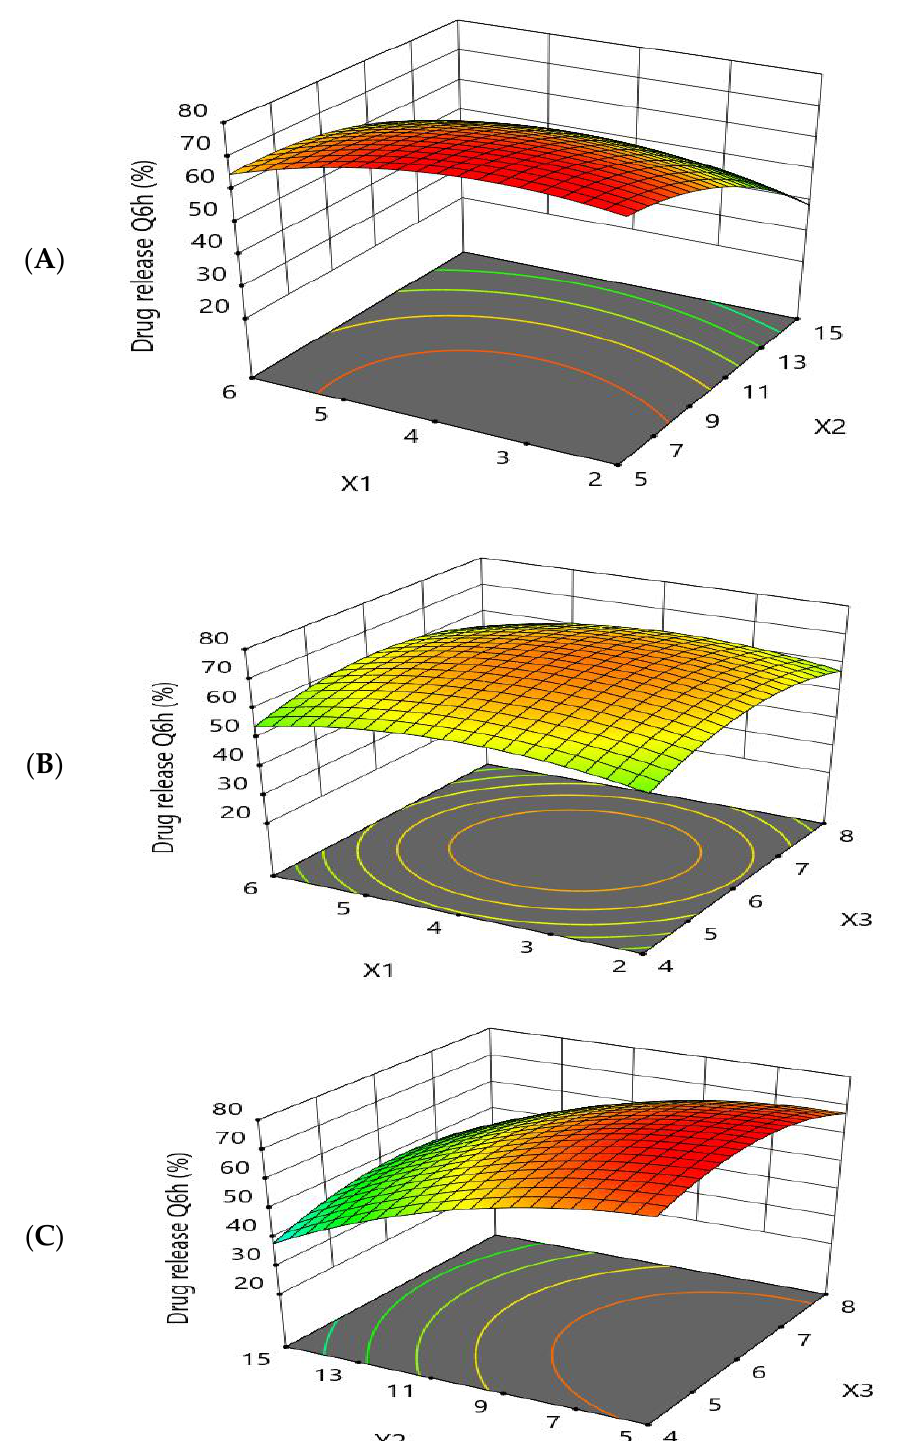
Figure 6. Response-surface-methodology plot for the effect of formulation factors (X1, X2, and X3) on the in vitro drug release Q6h (Y3). ( A ) Effect of sodium alginate concentration and cross-linker concentration on the in vitro drug release Q6h (Y3); ( B ) effect of sodium alginate concentration and sesame oil concentration on the in vitro drug release Q6h (Y3); and ( C ) effect of cross-linker concentration and sesame oil concentration on the in vitro drug release Q6h (Y3).